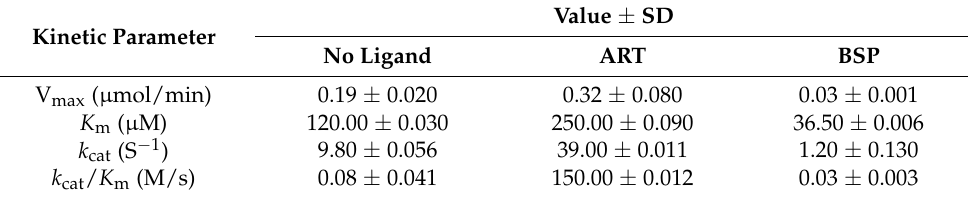
Table 1. Kinetic parameters of GSH towards Sbh26GST.